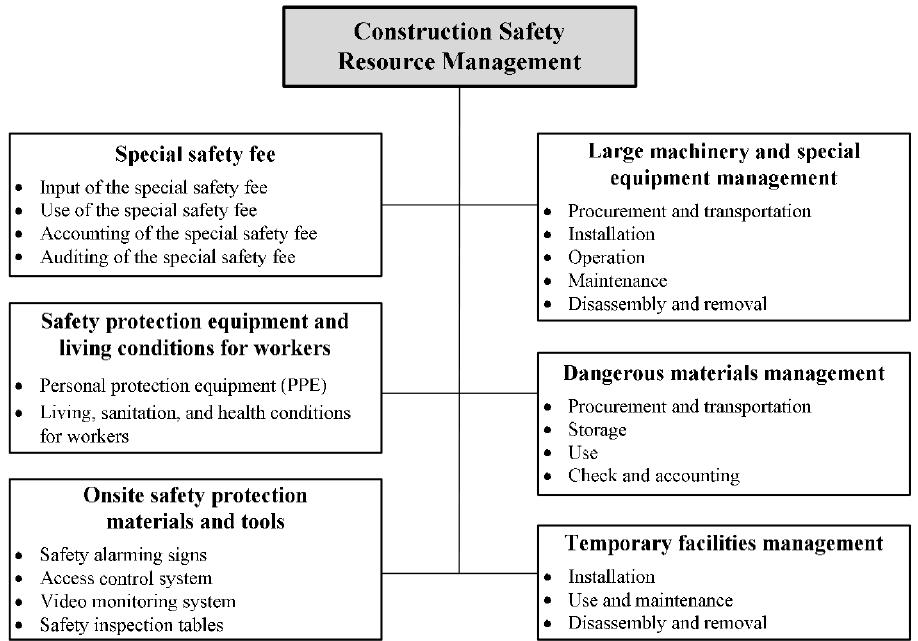
Figure 4. Structure of the safety resource management